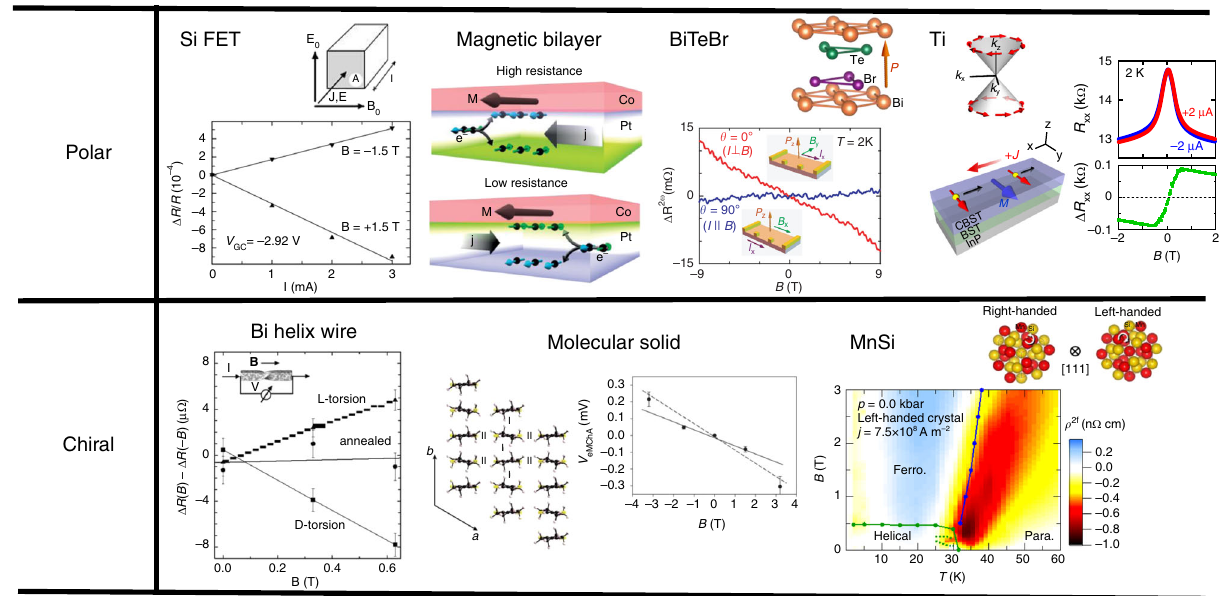
Fig. 3 Systems showing the unidirectional magnetoresistance. There are two classes according to the crystal symmetry, i.e., polar and chiral structures. Polar systems include Si FET 41 , magnetic bilayer 42 , BiTeBr 43 , and surface state of topological insulator (TI) 44 . In this class of systems, the resistivity R showing the magnetochiral anisotropy has the form R = R 0 [1 + γ ( P × B ) ·I ] where the directions of the polarization P , magnetic fi eld B , and the current I (electric fi eld E ) are orthogonal to each other. There are several microscopic mechanisms of the magnetochiral anisotropy. For Si FET 41 , the relativistic Lorentz transformation and associated correction due to the factor v/c ( v : velocity of electrons, c : velocity of light) was proposed 41 . For magnetic bilayer Ta| Co and Pt|Co systems, it has been proposed that the current-induced spin accumulation modi fi es the resistivity through the spin – orbit interaction and spin- dependent scattering 42 . The asymmetric band dispersion under the in-plane magnetic fi eld in the presence of the Rashba spin – orbit interaction is identi fi ed as the origin of the nonreciprocal resistivity in BiTeBr 43 , while the asymmetric scattering of electrons by magnons is the origin in the surface state of topological insulator (TI) 44 . The examples of the other class, i.e., the chiral structure, are shown in the lower part, which shows the behavior R = R 0 [1 + γ ( B·I )] called the electrical magnetochiral effect. Examples of this class include Bi helix 40,46 , molecular solid 47 , and MiSi 48 . The helix structure is a representative example of this class. It has been discussed that the magnetic fi eld b produced by the current is combined to the external magnetic fi eld B , and the magnetoresistance for b + B results in the electrical magnetochiral effect in Bi helix 40 . Similar effect was also observed in a molecular semiconductor [DM-EDT-TTF] 2 ClO 4 (middle of the lower panel) 47 . In a ferromagnet, the time-reversal symmetry is spontaneously broken, and the chiral ferromagnet can show the electrical magnetochiral effect. MnSi is a representative example, and that effect is enhanced above the helical transition temperature T c 48 . This suggests that the spin fl uctuation of chiral nature is the origin of the electrical magnetochiral effect. Reprinted fi gures with permission from ref 40,41,45 . Copyright (2001, 2005, 2016) by the American Physical Society. Figures from ref. 42 – 44,47,48 with permission from